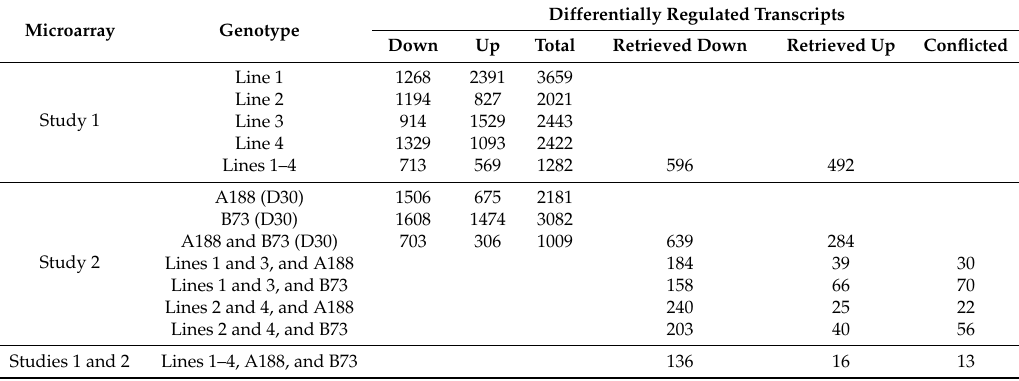
Summary of six genotypes gene expression pattern under low versus sufficient nitrogen